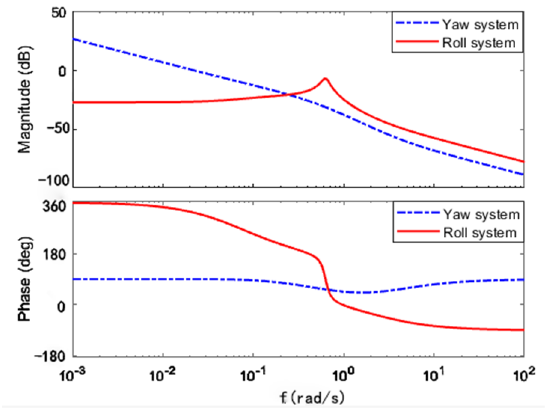
Figure 2. Bode plot of system.